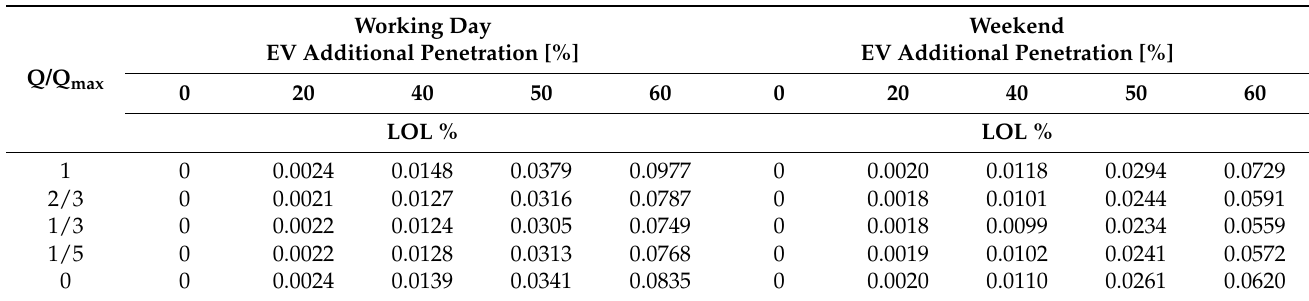
Table 7. LOL for different levels of reactive power for the T 2 for different additional penetration